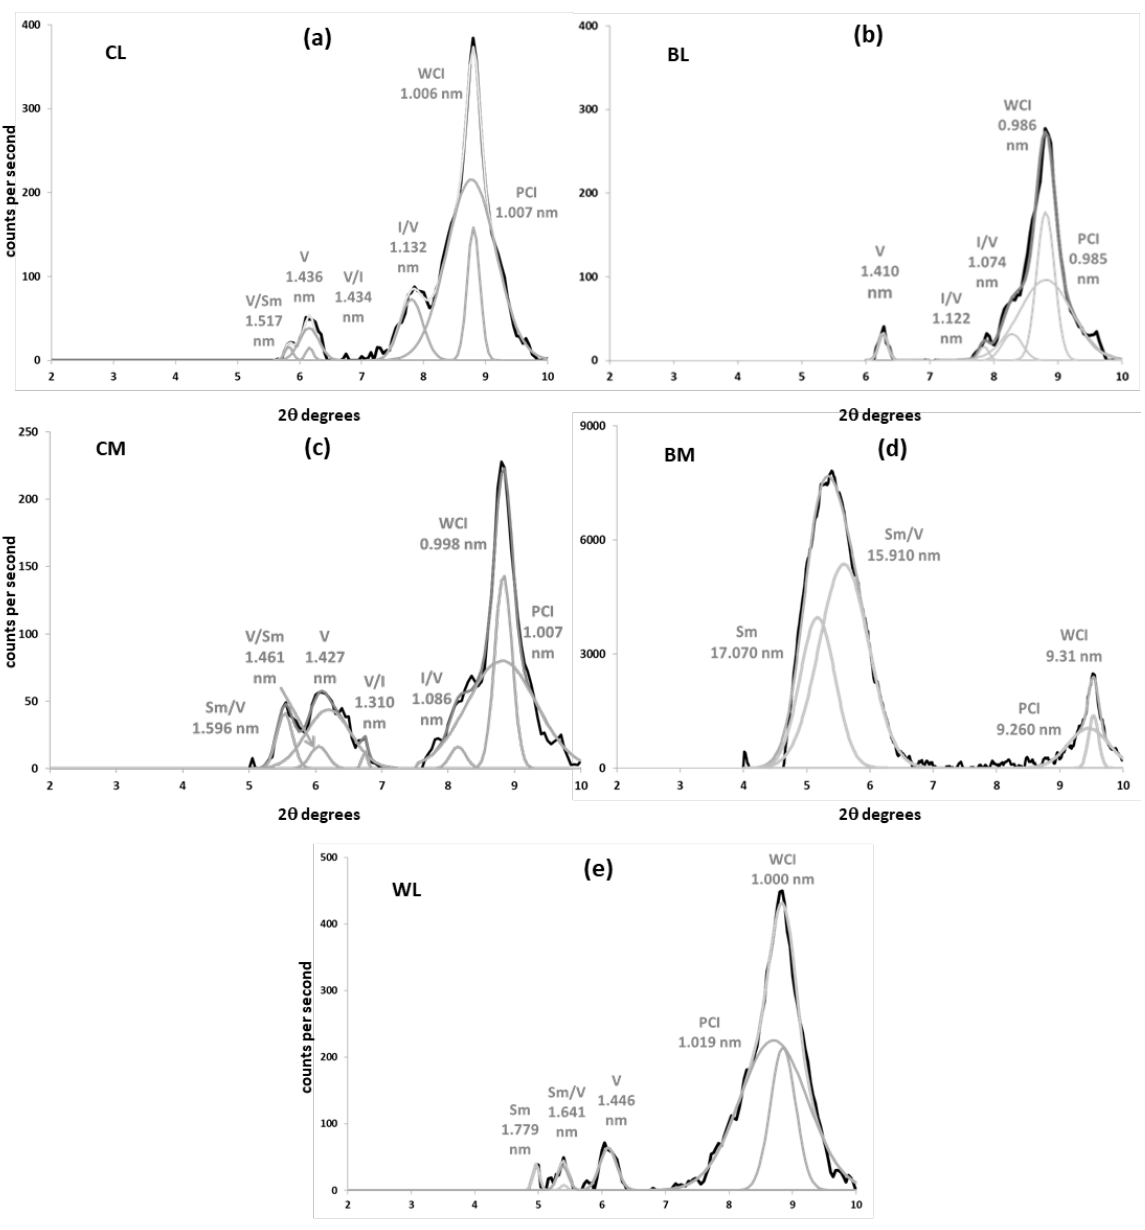
Figure 3. Peak decomposition of XRD patterns of oriented mounts (3 – 10° 2θ) from clay fraction of the calcareous soils (Mg-saturated and EG-solvated). Black: experimental pattern; Grey: simulated pattern. ( a ) Cover-crop soil over limestone colluvia (CL); ( b ) bare soil over limestone colluvia (BL); ( c ) cover-crop soil over marls (CM); ( d ) bare soil over marl (BM); ( e ) woodland soil over limestone colluvia (WL). Sm: smectite; Sm/V: smectite – vermiculite mixed-layer; V/Sm: vermiculite – smectite mixed layer; vermiculite; V/I: vermiculite – illite mixed-layer; I/V: illite – vermiculite mixed-layer; V: vermiculite; PCI: poorly crystalized illite; WCI: well-crystalized illite.